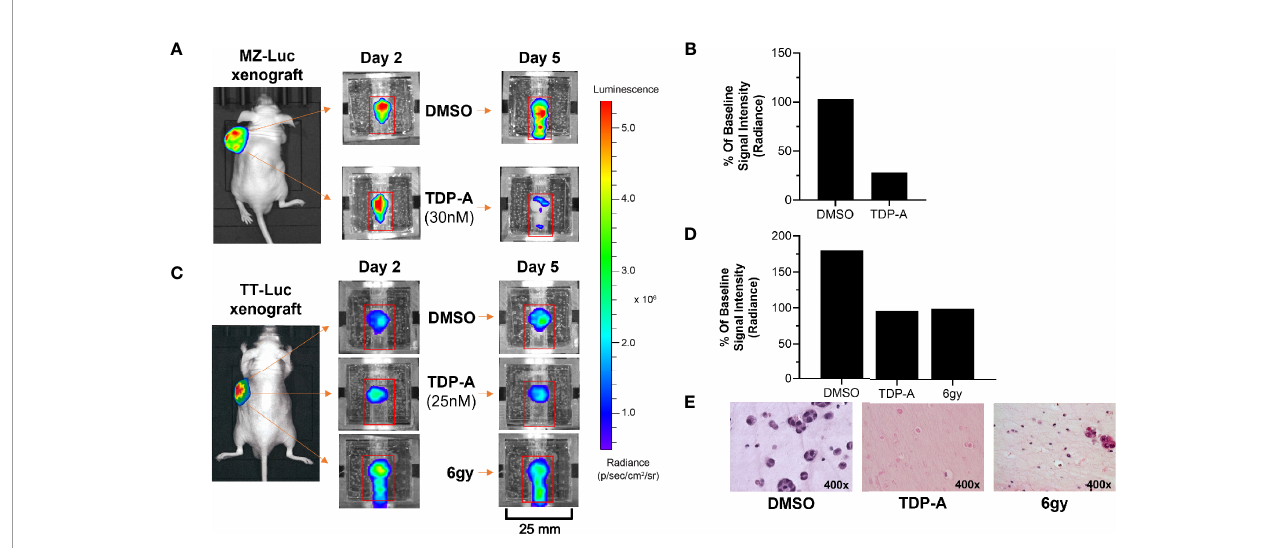
FIGURE 3 | NET responses to anti-cancer therapeutics can be detected within the bioreactor. (A, B) MZ-Luc and (C, D) TT- Luc cells (5x10 6 cells) were injected into nude mice and established for 2 weeks. Tumors were then implanted into the bioreactors for therapeutic testing. (B) A time-dependent decrease in bioluminescence signal of and MZ-Luc surrogate perfused with a 30nM dose of TDP-A showed a decrease from days 2 to 5 compared to DMSO control. (D) A similar result was detected in TT-Luc xenografts treated with either a 25 nM dose of TDP-A or a one-time radiation dose of 6 gy. (E) Sections of TT-Luc surrogates at day 5 depict decreased cell density and size in treated